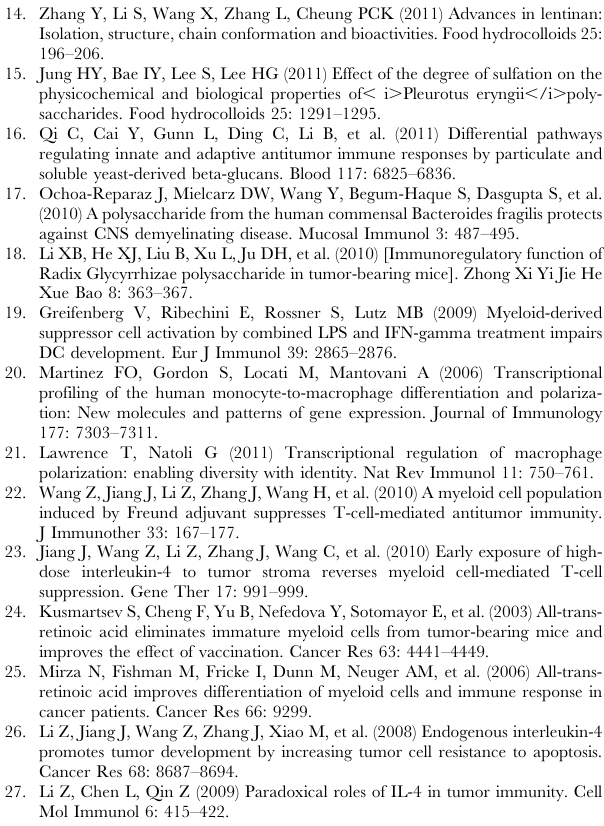
Table S1 The relationship between 13 C NMR chemical shift and the corresponding